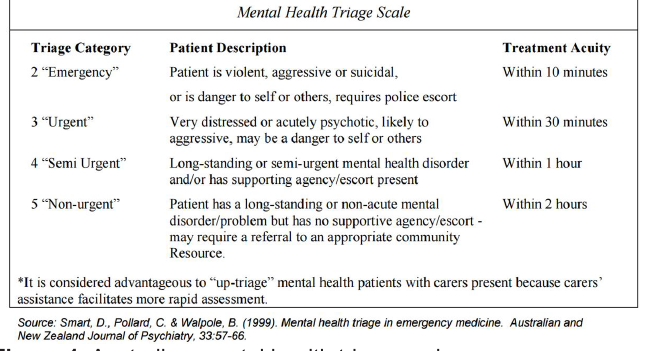
Figure 1 . Australian mental health triage